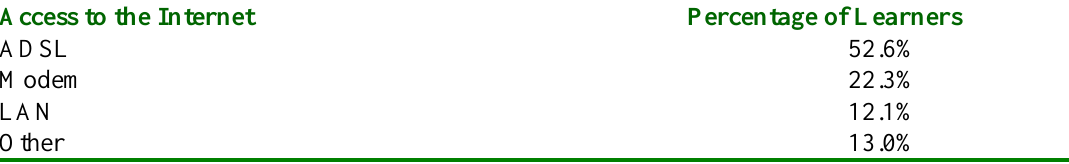
Table 11. Learner access to the Internet Access to the Internet